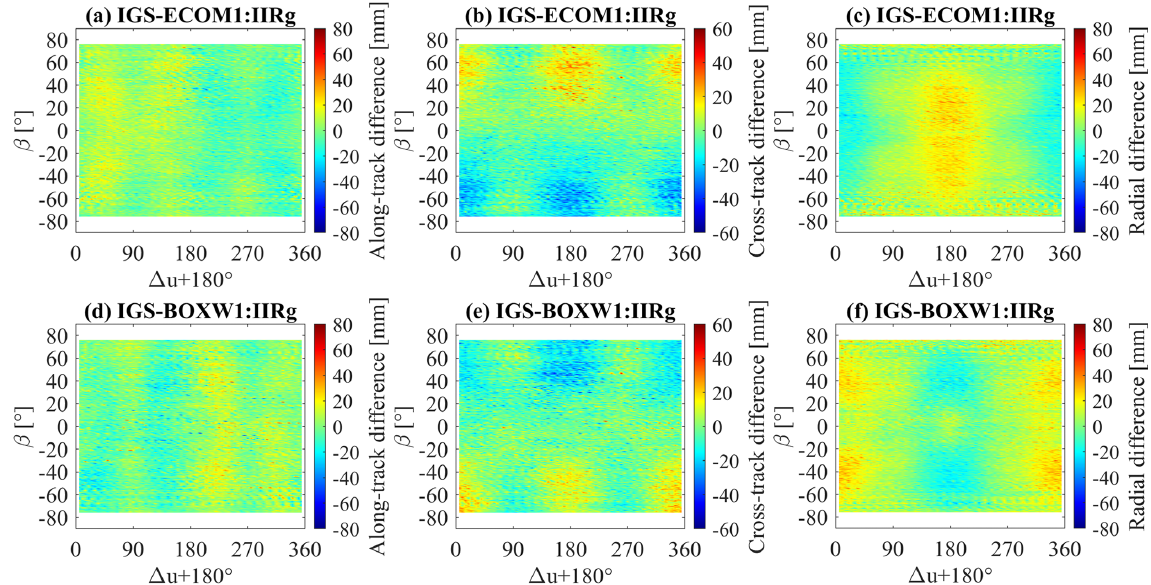
Figure 1. Orbit differences between IGS and ECOM1 (a–c) , IGS and BOXW1 (d–f) in along-track, cross-track and radial directions for Block